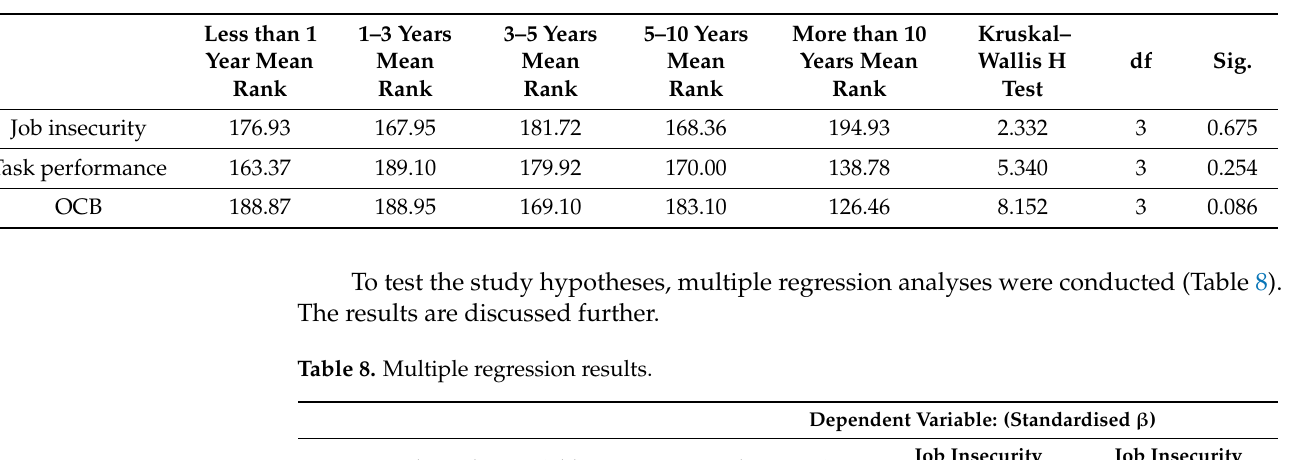
Table 7. Working years’ differences in job insecurity, task performance and OCB (Kruskal–Wallis H test).